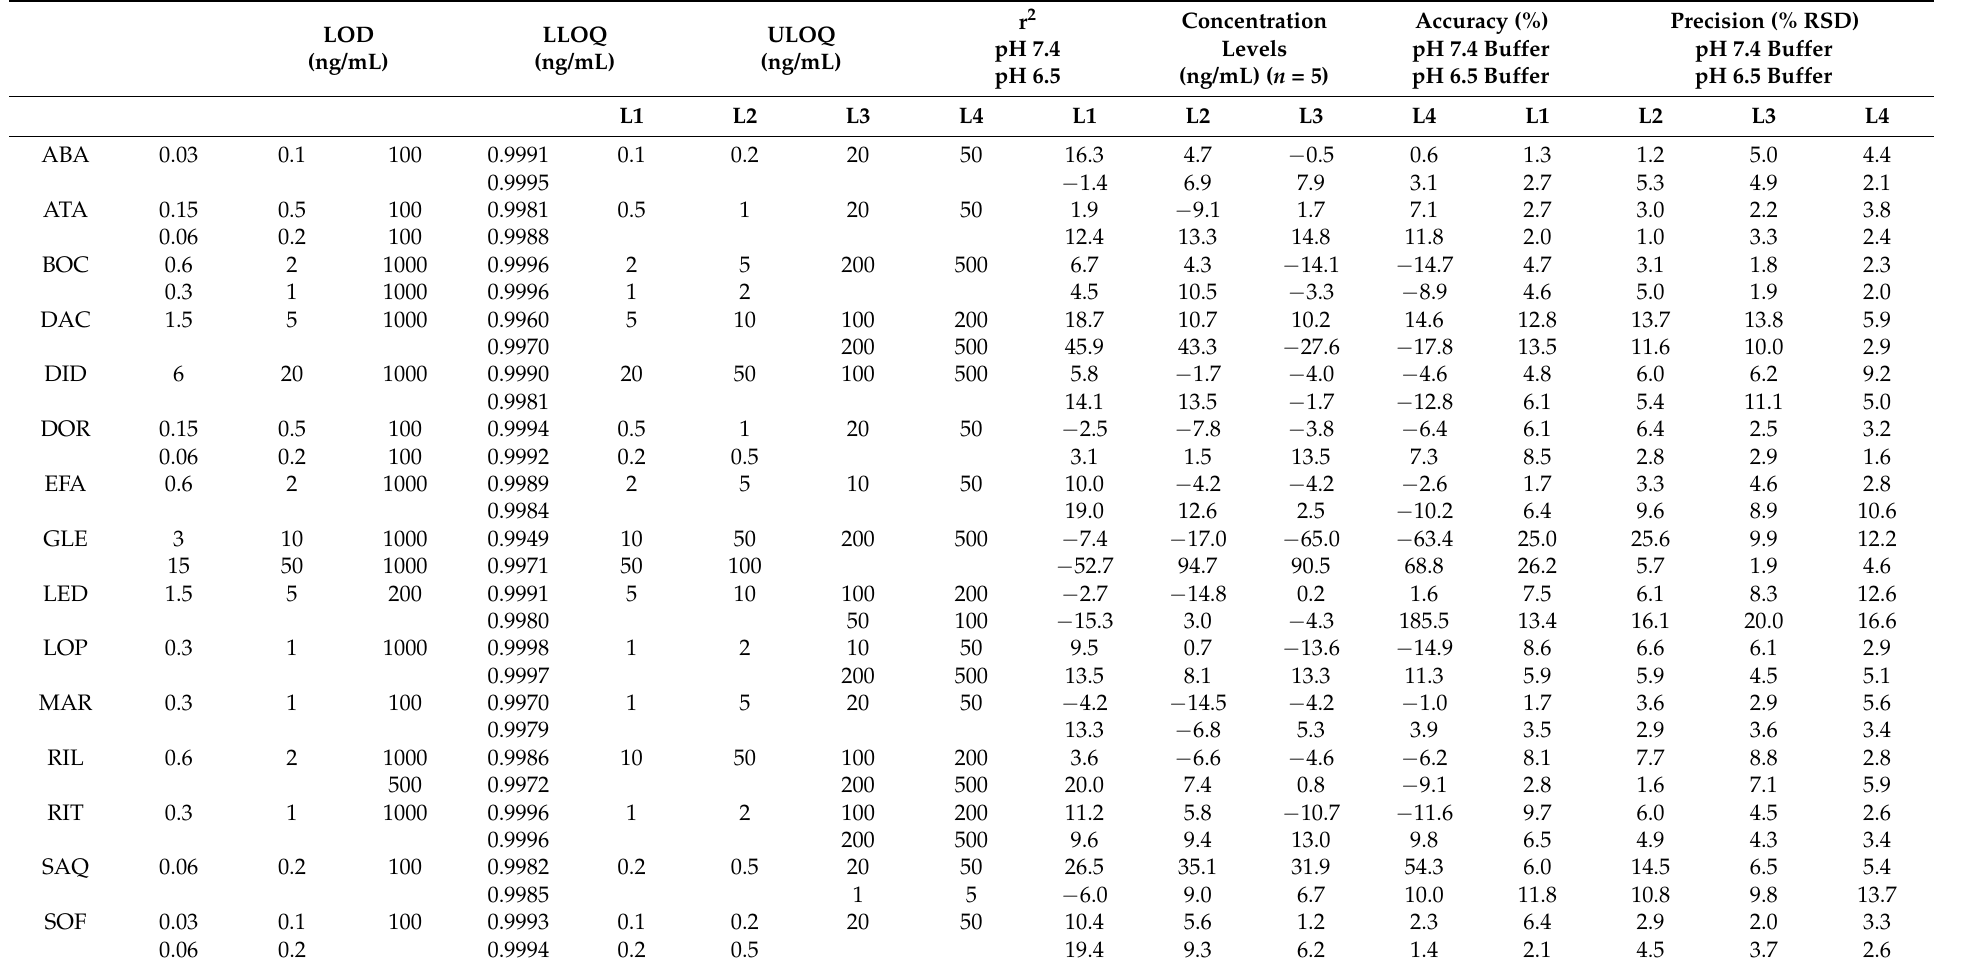
Table 2. Method validation results for